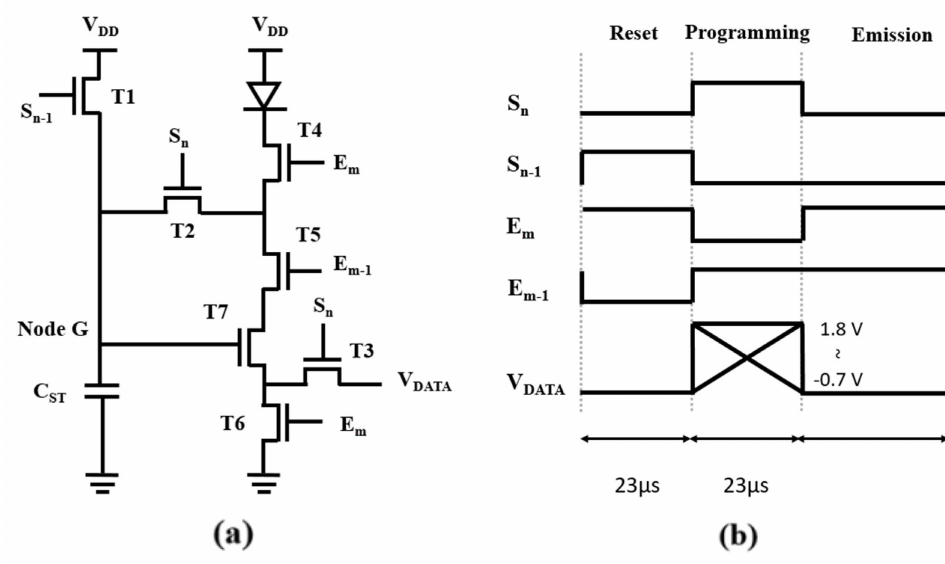
Figure 1. Proposed pixel circuit. ( a ) Circuit schematic. ( b ) Operation timing